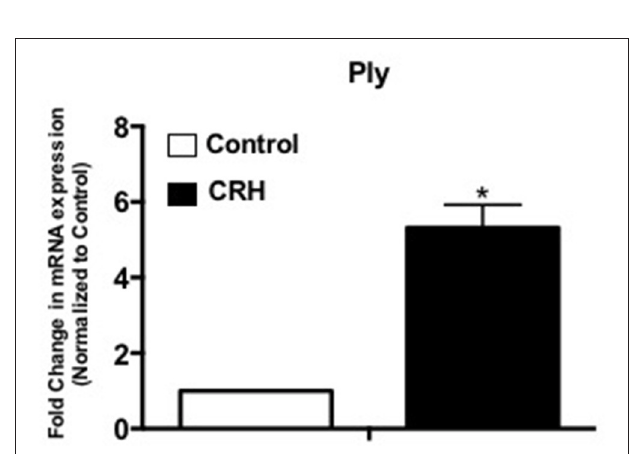
FIGURE 4 | CRH increases Ply mRNA expression of Serotype 1 pneumococcal strain . Serotype 1 pneumococcal strain was grown in the presence or absence of CRH (4.0 × 10 − 4 mM/ µ l) for 5 h. Ply gene expression was determined by quantitative Real-Time PCR analysis. Data represents mean ( n = 3) ± standard deviation in the fold increase in Ply of mRNA expression compared to control. Asterisks (*) indicate significant ( P ≤ 0.05) difference between CRH and